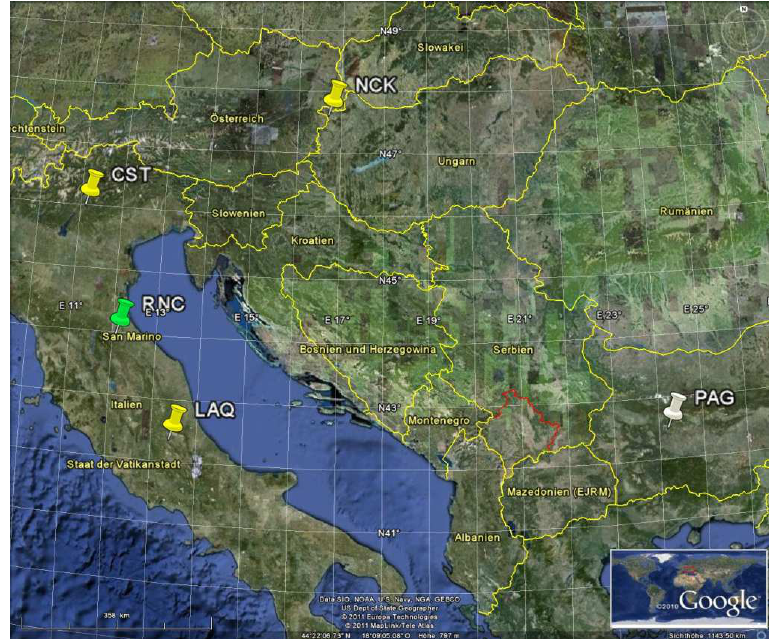
Fig. 1. Map of SEGMA ULF stations, Google